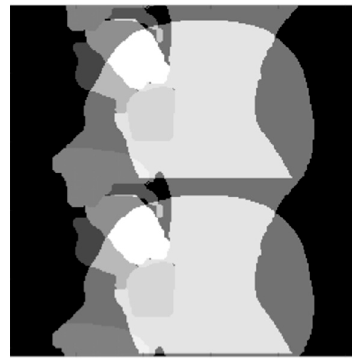
Figure 10. A frame from the blipped Echo Planar Imaging (EPI) simulation exhibiting Nyquist N/2 ghosting due to misalignments in the centres of odd and even k-space lines.